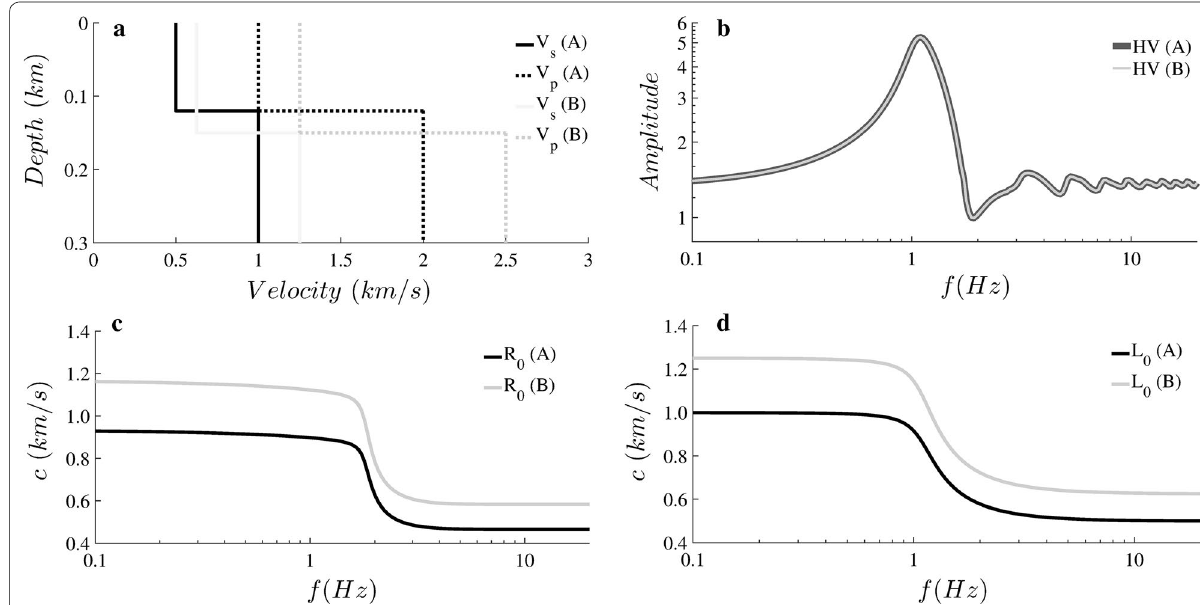
Fig. 4 a Two layered media profiles and their associated, b H / V , c Rayleigh and d Love fundamental mode dispersion curves (after Piña‑Flores et al.